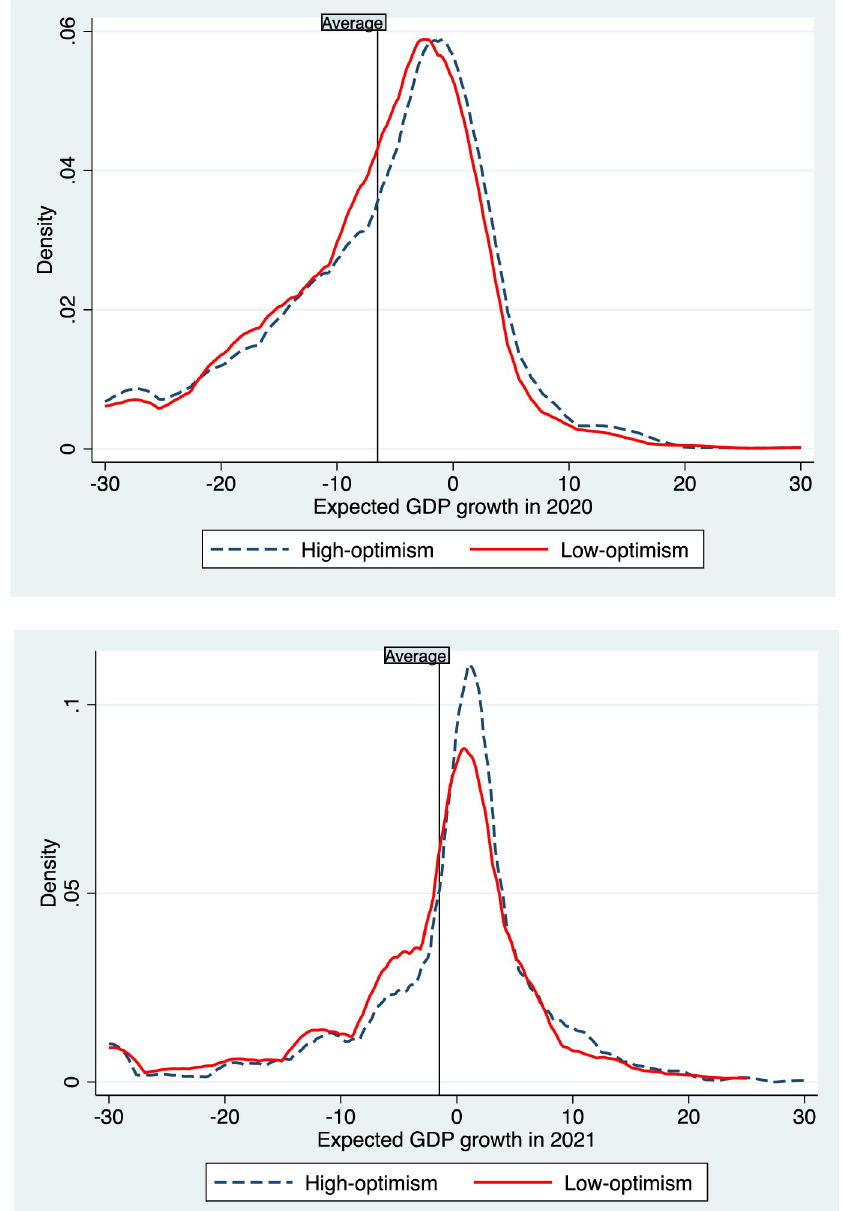
Fig 4. Optimism and macroeconomic expectations. The upper (lower) graph illustrates the kernel density of the responses to a question which asks entrepreneurs to estimate the GDP growth in the UK in 2020 (2021). The histograms are reported separately for entrepreneurs below and above the median threshold of optimism. The vertical lines denote the average